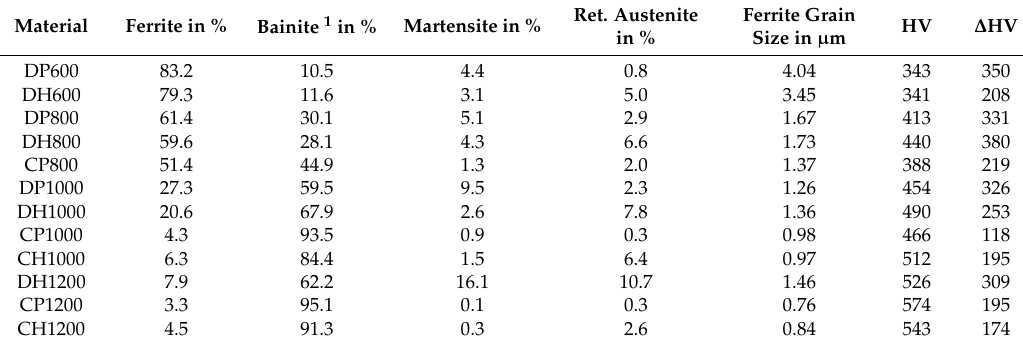
Table 5. Microstructural